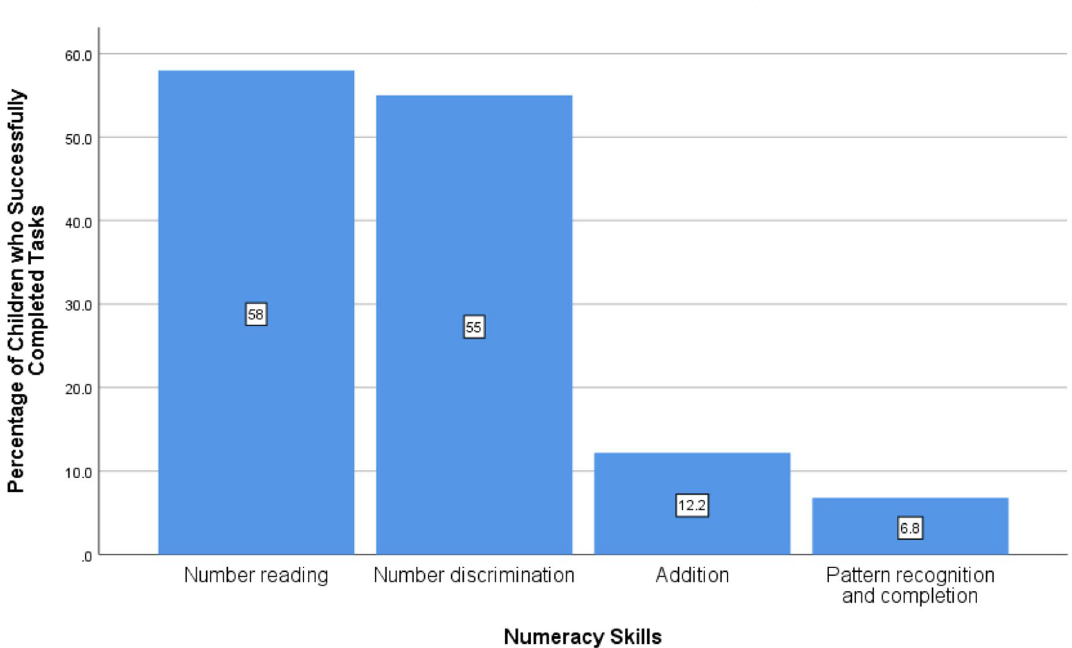
Figure 2. Foundational Numeracy skills of Children of Age 5–17 Years of Punjab. Source: MICS